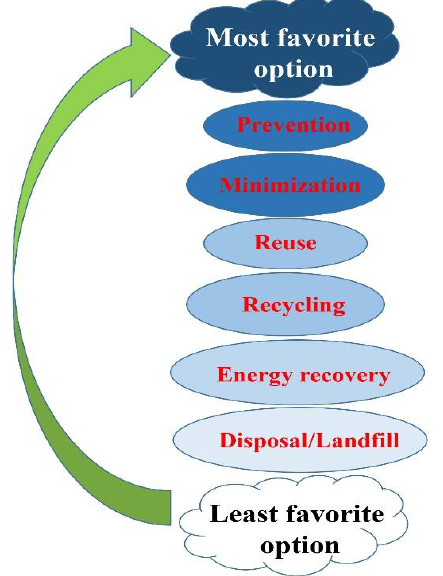
Figure 5. A schematic illustration of concepts of waste management. The hierarchy of